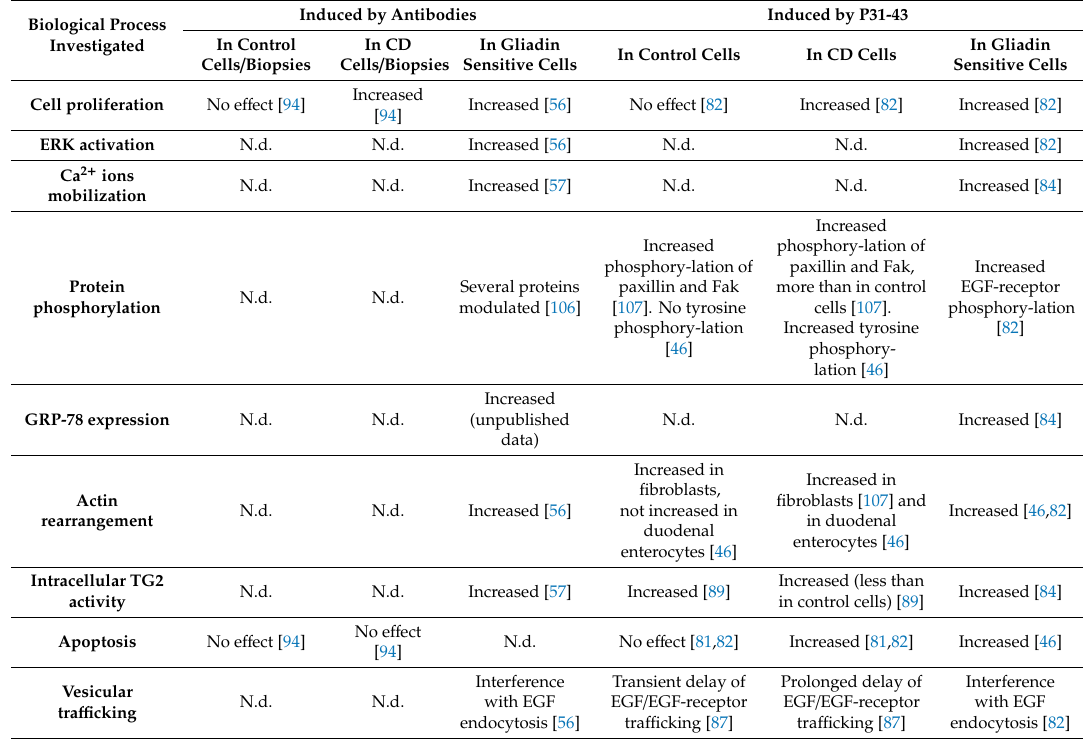
Table 2. Comparison between biological e ff ects induced by anti-TG2 antibodies and the same / similar e ff ects induced by P31-43 in control cells / biopsy cultures, in CD cells / biopsy cultures and in gliadin-sensitive cells (Caco-2 and T84 cells). N.d. not